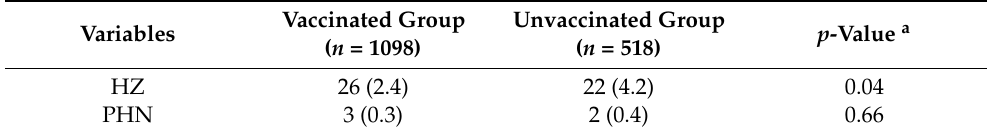
Table 2. Clinical diagnosis of the study subjects.